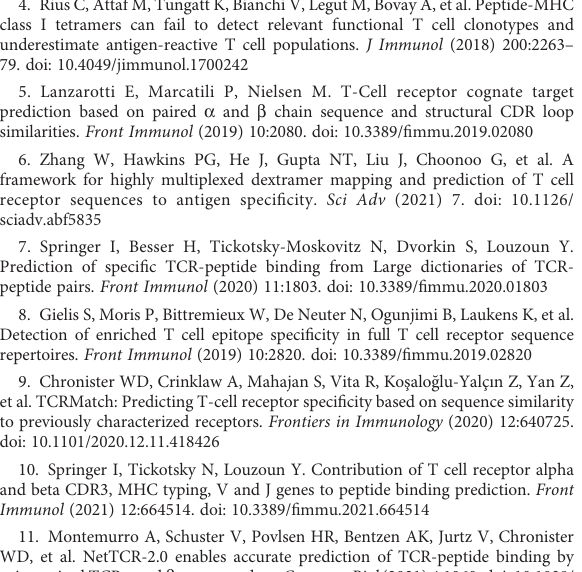
SUPPLEMENTARY FIGURE 4 Peptide-speci fi c AUC01 and PPV values comparison of the NetTCR models trained using the set of all CDRs or CDR3 only. The predictive power is evaluated for each peptide (average and w_average refer to an average and weighted average, respectively, of the peptide-speci fi c scores). The performance is also differentiated based on the positives vs. 10X/swap negatives predictions.